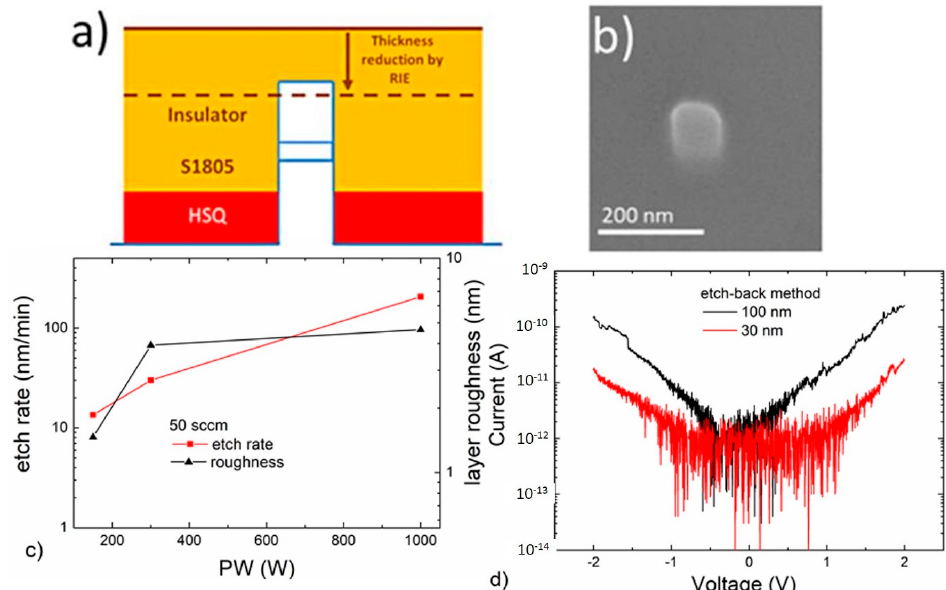
Figure 4. a ) Schematic for the etch-back (RIE planarization) method. b) SEM image where the